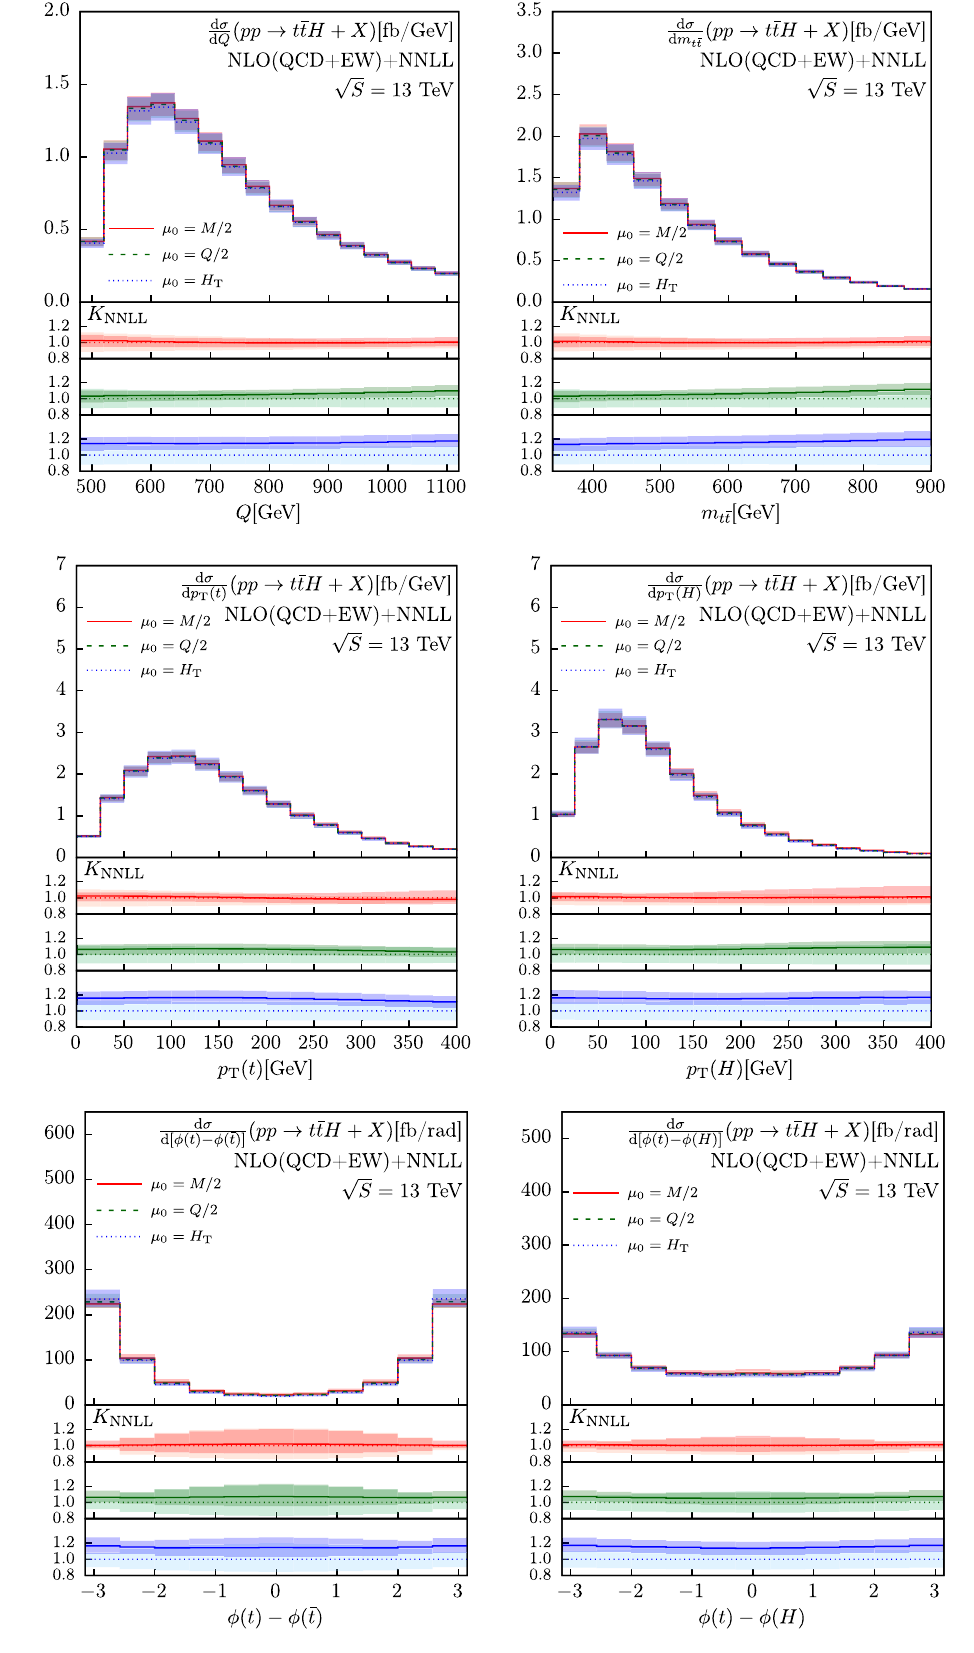
Fig. 10 Predictions for pp → t ¯ tH differential cross section in Q and m t ¯ t . Lower panels show ratio of the NLO(QCD + EW) + NNLL and NLO(QCD + EW) distributions for three central scale choices μ